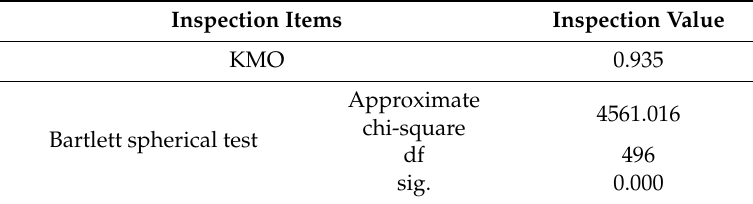
Table 4. Kaiser–Meyer–Olkin (KMO) and Bartlett spherical